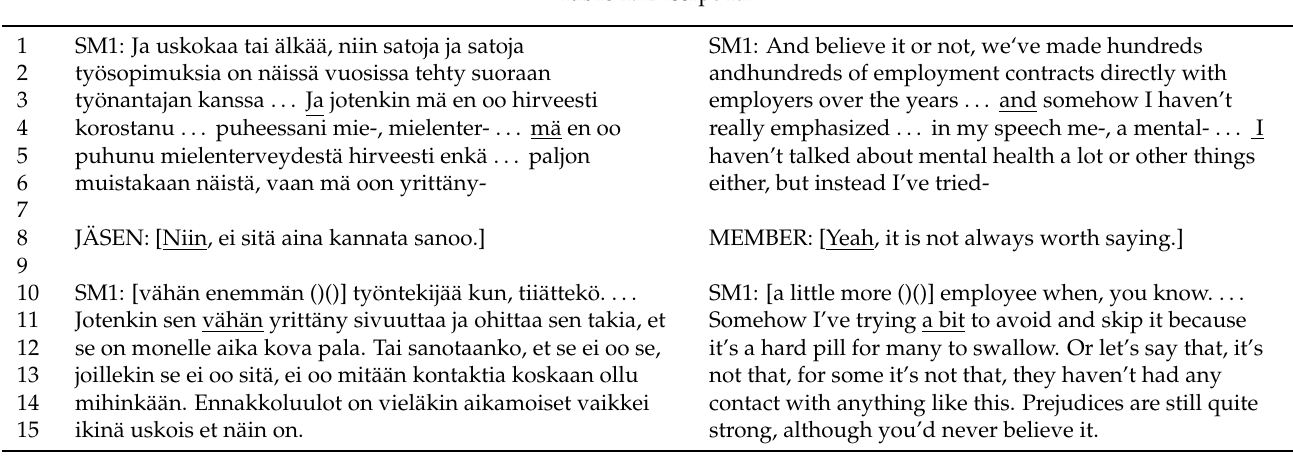
Table 1. Excerpt